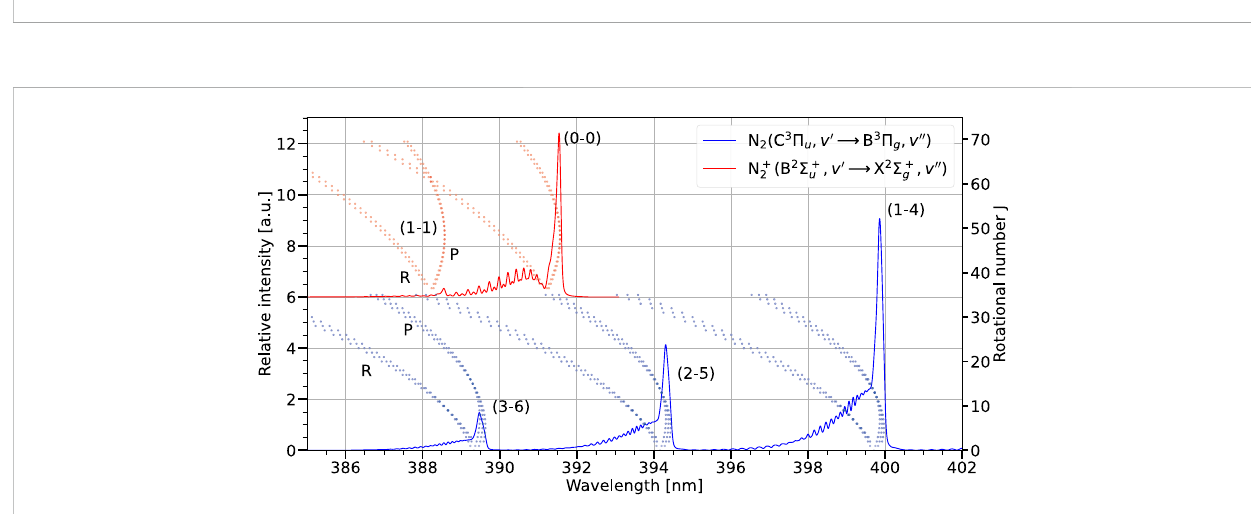
FIGURE 7 SeparatedsimulationofFNSandSPSvibrationalbandswithincreasedspectralresolutionincomparisontoourtypicalmeasurements.Forillustrative purposes, the individual major rotational branches are displayed as dots. For clarity, the relative intensity and rotational number of FNS have been shifted up by 6 and 35, respectively. Where the numbers in brackets represent higher ( ] ′ ) and lower ( ] ′′ ) vibrational states, respectively. MassiveOES databases used for the simulation are based on [33 –